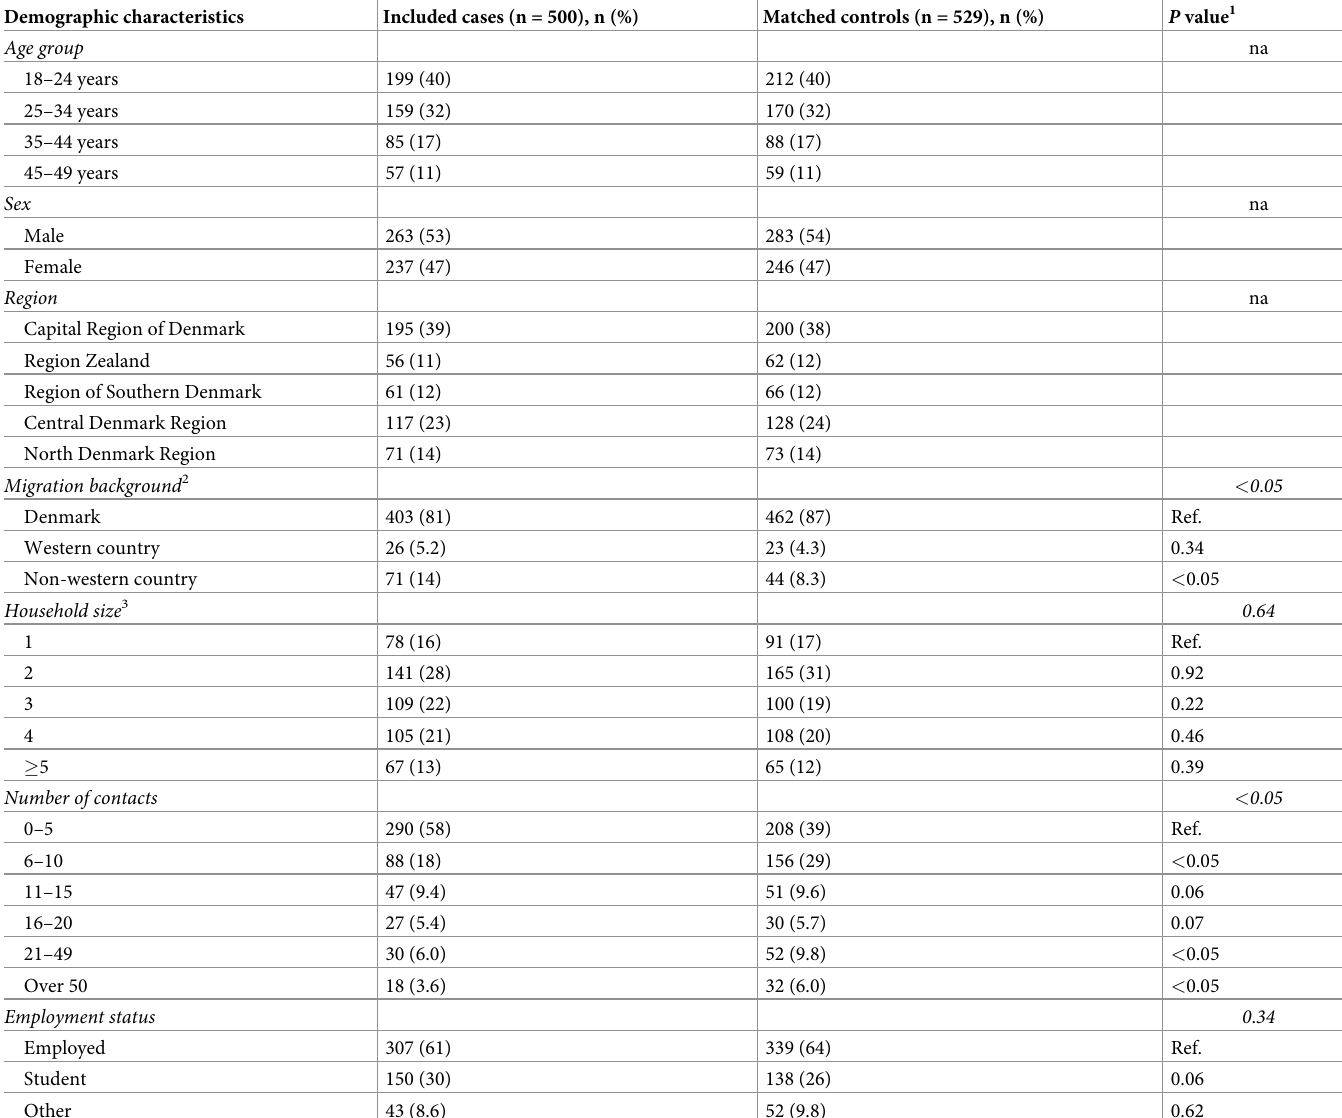
Table 1. Number and proportion of included cases and controls by demographic characteristics and p–value of test for deviations, Denmark, June 2021. Demographic